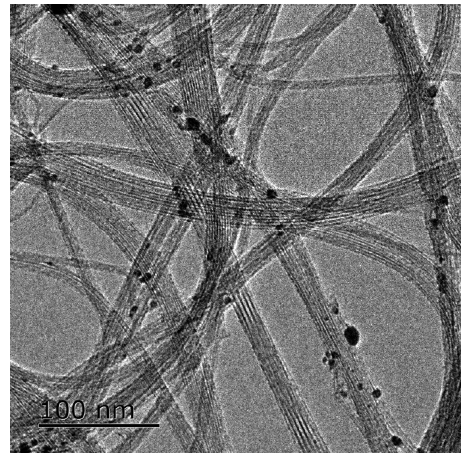
Figure 1: TEM image of V - SWCNTs.